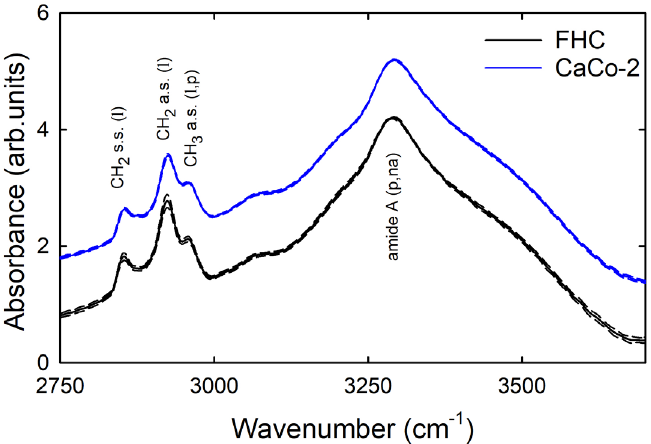
Figure 1. Mean FTIR spectra of healthy FHC (continuous black line) and cancerous CaCo-2 (continuous blue line) cells after SNV normalisation. Standard deviation spectra are also reported as dashed lines. The assignment of vibrational modes is also reported (na: nucleic acids; p: proteins; l: lipids; s.s.: symmetrical stretching; a.s.: asymmetrical stretching). The spectra are vertically shifted for clarity purpose.